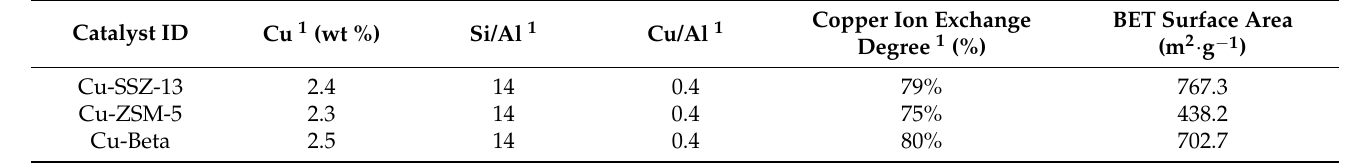
Table 1. Chemical composition of the copper-based zeolites.